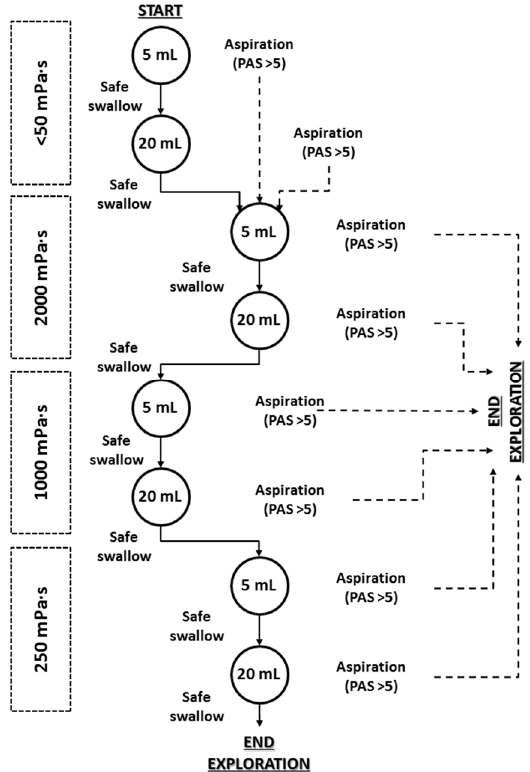
Figure 3. Study algorithm and safety stop rule for the videofluoroscopic exploration of the therapeutic effect of the different levels of viscosity. PAS: penetration-aspiration scale.